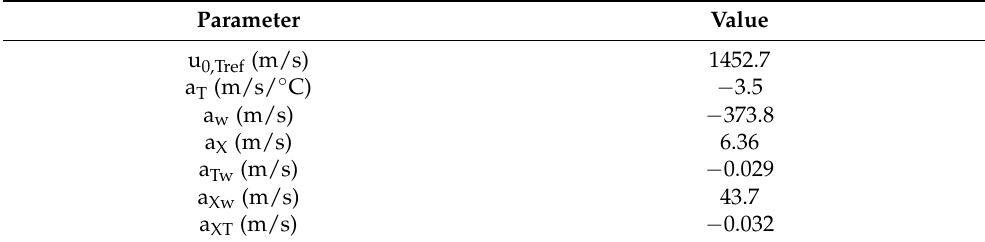
Table 1. Optimal parameters for Equation